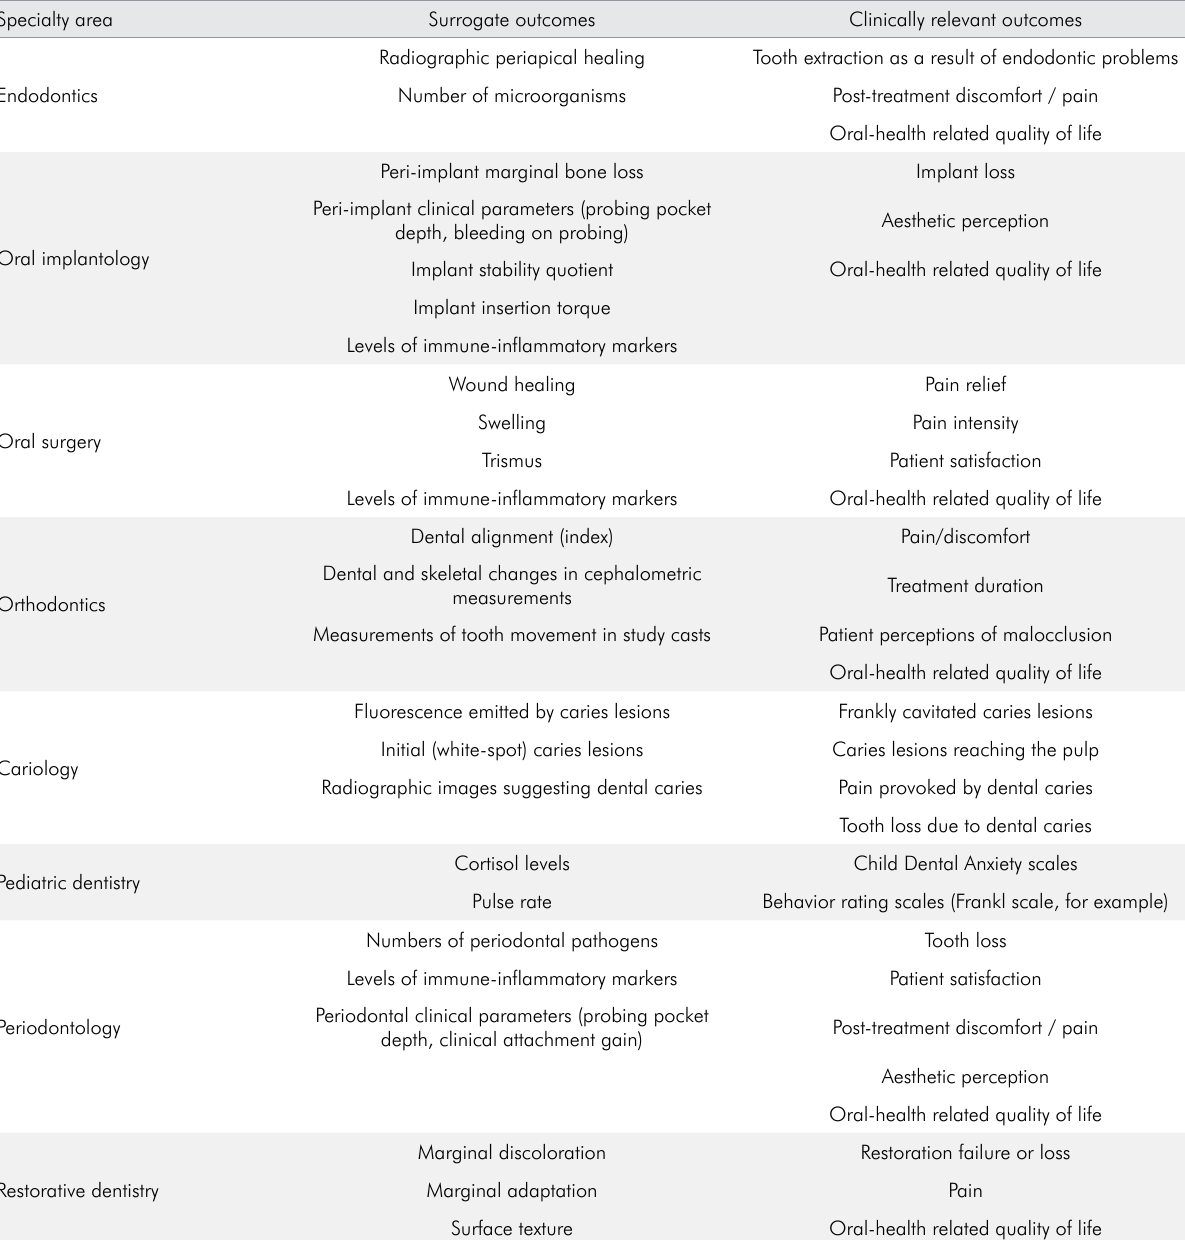
Table 1. Clinically relevant and surrogate outcomes that are frequently used in Dentistry. Specialty